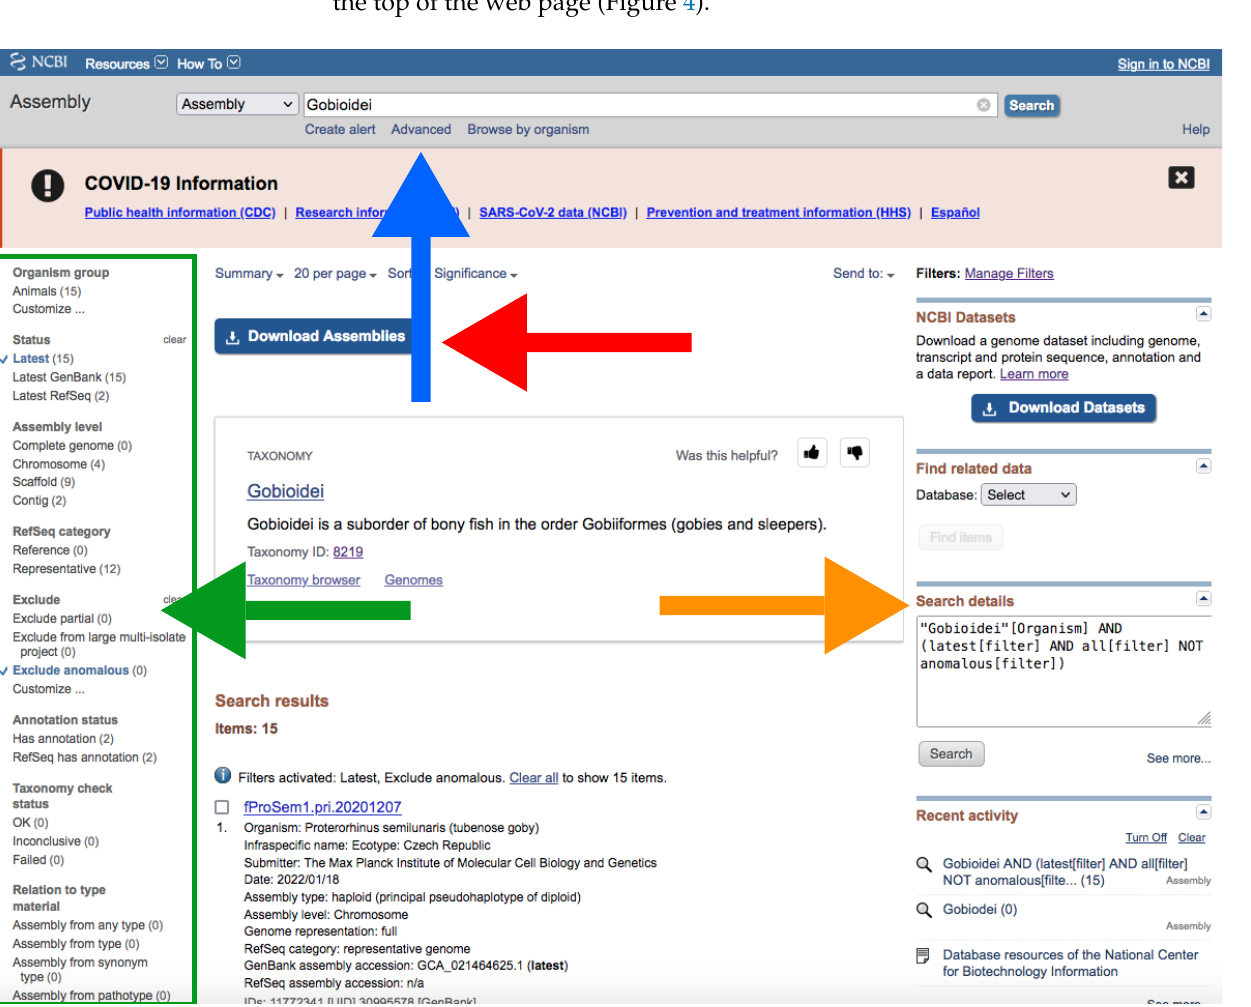
Figure 4. NCBI web server interface after conducting a search on assembly database. The blue arrow indicates the search box; the green arrow and green square indicate Representative and the filters side panel, respectively; the orange arrow indicates “Search details”; the red arrow indicates the Download Assemblies button (see Figure 5 for more information about downloading). Accessed on 27 January 2022.